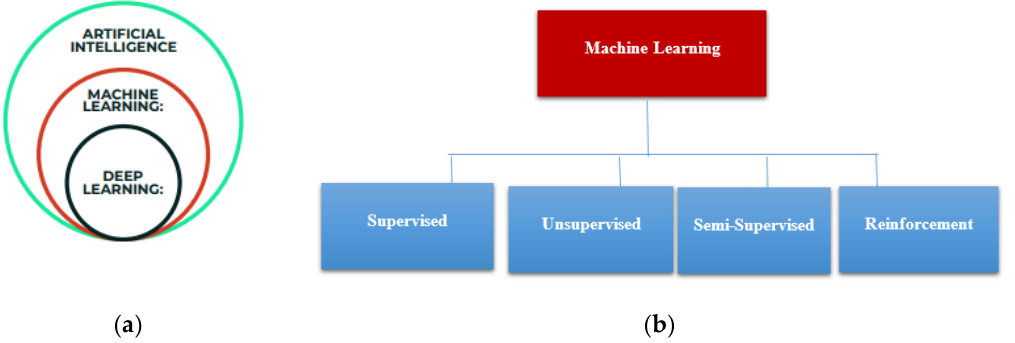
Figure 1. ( a ) Representation of Artificial Intelligence and its subfields; ( b ) Components of machine learning.